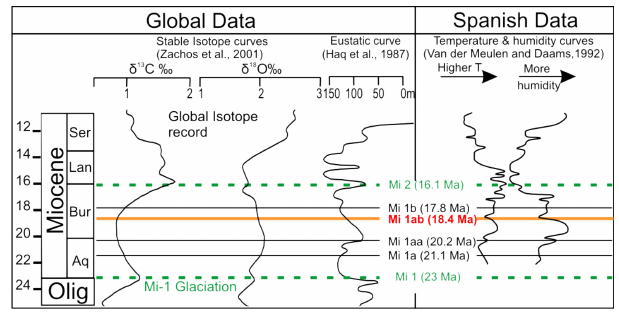
Figure 5. Correlation of the Oligocene–Miocene of the global deep- sea carbon and oxigen isotope curves of Zachos et al. (2001), with the Haq et al. sea-level curve (Haq et al., 1987). The main signif- icant ages of the Miocene oxigen isotope events (Mi events) are shown (Miller et al., 1991). The green Mi 1 event corresponds to the Oligocene–Miocene glaciation produced during the Oligocene– Miocene limit. The red line corresponds to the Mi-1ab, the time at which the mirabilite deposits (thenardite precursor) of the Tajo basin were formed. The absolute ages are relative to the USGS Chronostratigraphic Chart